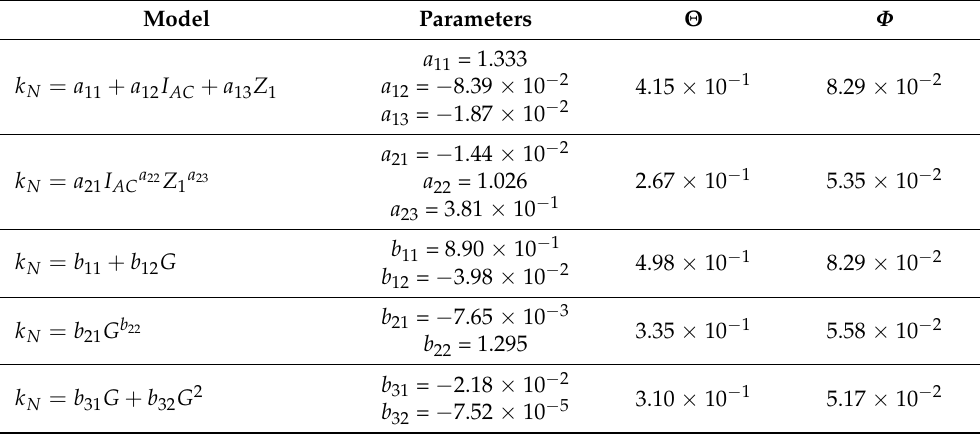
Table 2. Estimated parameters of the models for predicting the Norrish constant ( k N ) from infor- mation indices ( I AC : information index on atomic composition; Z 1 : first Zagreb index; G : global information index; Θ : sum of squared errors; φ : statistical quantity defined by Equation